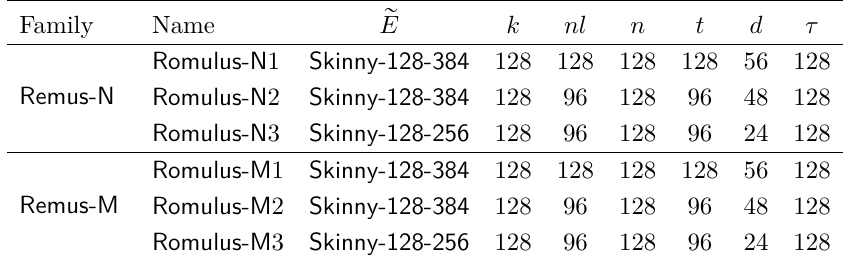
Table 5: Members of Romulus